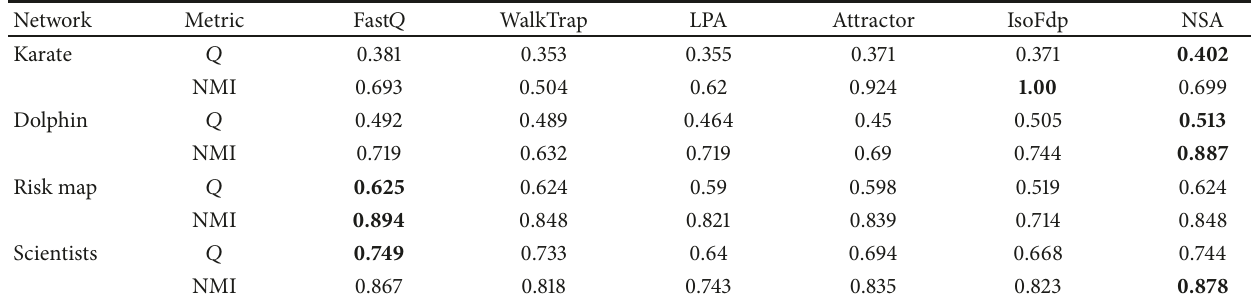
Figure 5: The dolphin social network . (a) The ground-truth community structure. (b) The community structure identified by our proposed method, NSA. Table 3: The experimental results on networks with ground-truth community structures. The largest values of the two measure metrics are typed in